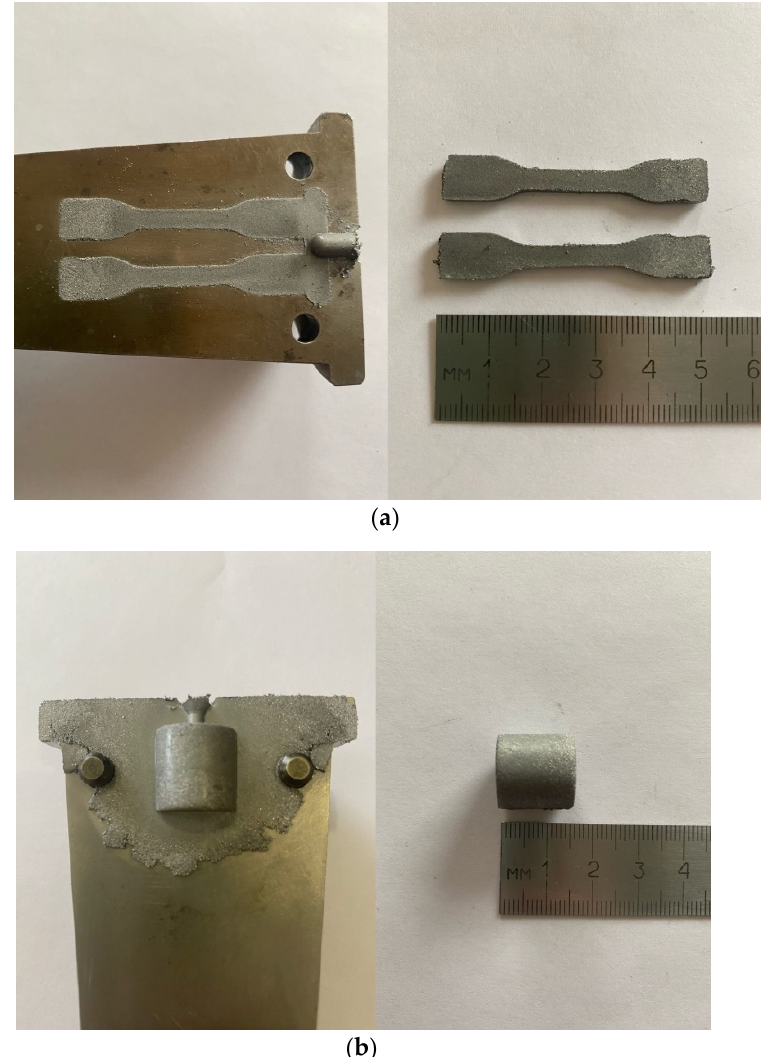
Figure 16. Samples in the form of a standard specimen for mechanical testing ( a ) and a cylinder ( b ), obtained by injection molding.